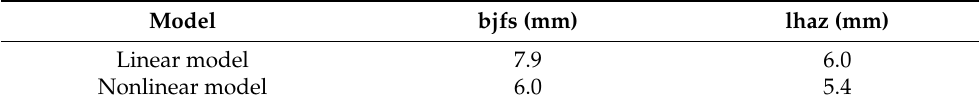
Table 3. The RMSE index of bjfs and lhaz CORS height fitting.